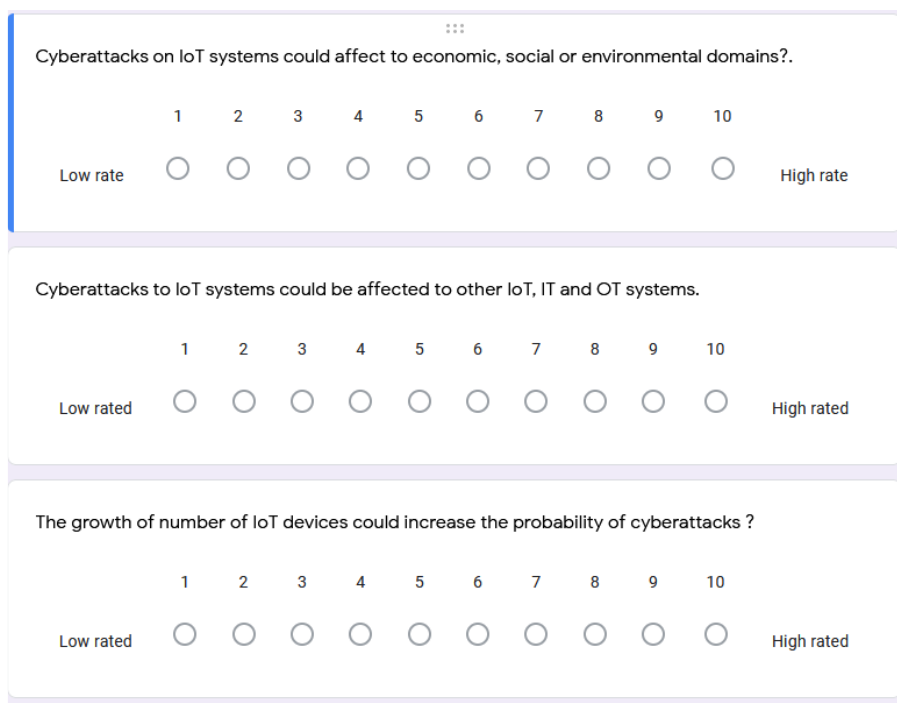
Figure 16. Extract of survey to obtain information from experts related to IoT security.